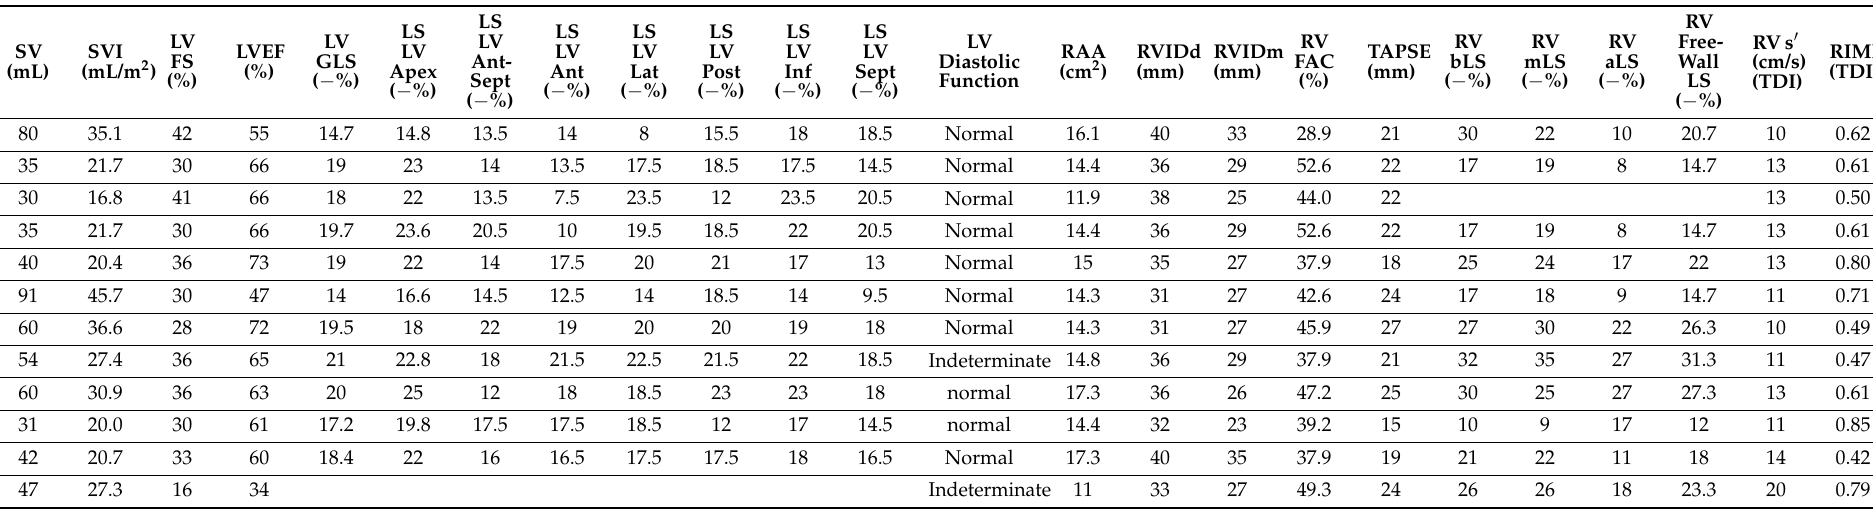
Table 3. Parameters describing left ventricular (LV) and right ventricular (RV) function in echocardiography performed at a median of 51 months after completion of radiotherapy involving the